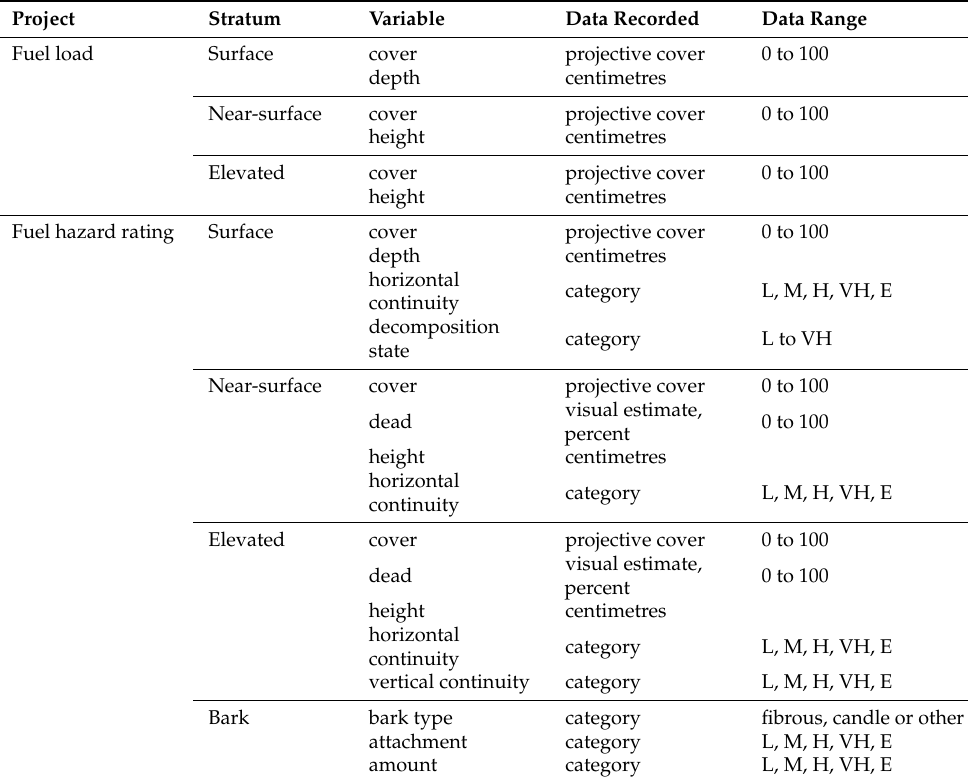
Table A5. Field Data Collected. Fuel load and fuel hazard rating data